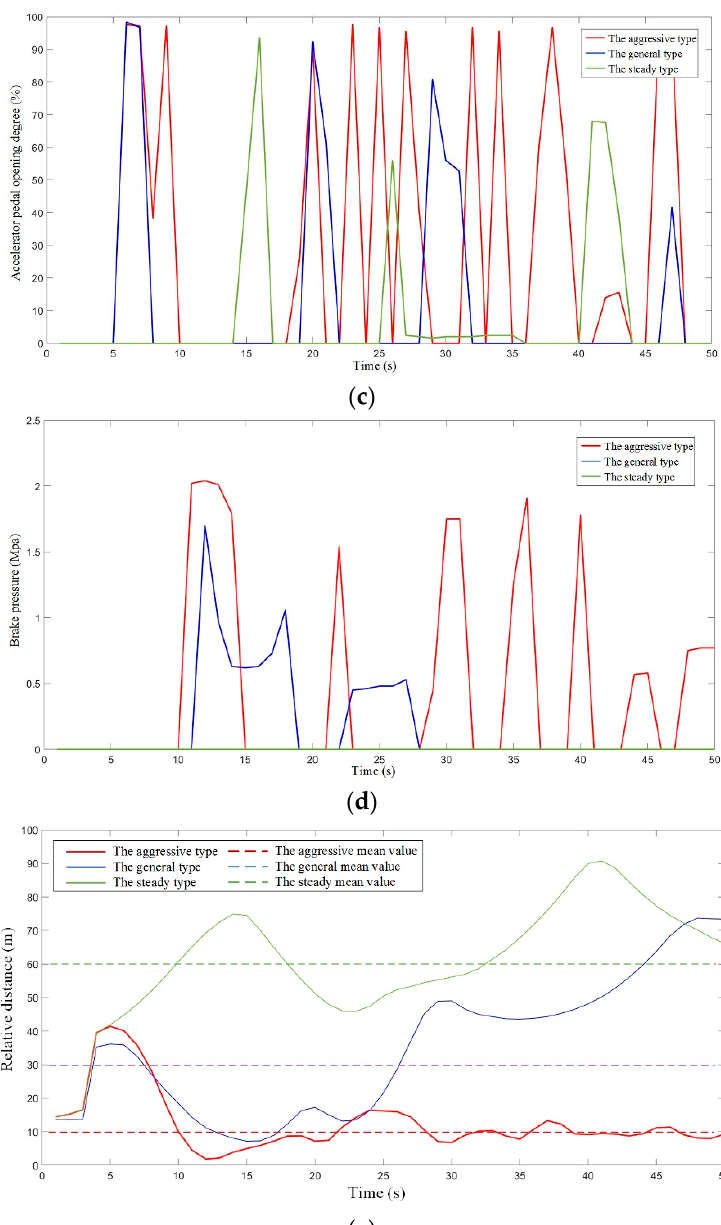
Figure 3. The experimental results for the curves after fitting with the three driving types: ( a ) the velocity for three driving types; ( b ) the acceleration for the three driving types; ( c ) the accelerator pedal degree for the three driving types; ( d ) the brake pressure for the three driving types; and ( e ) the relative distance for the three driving types.